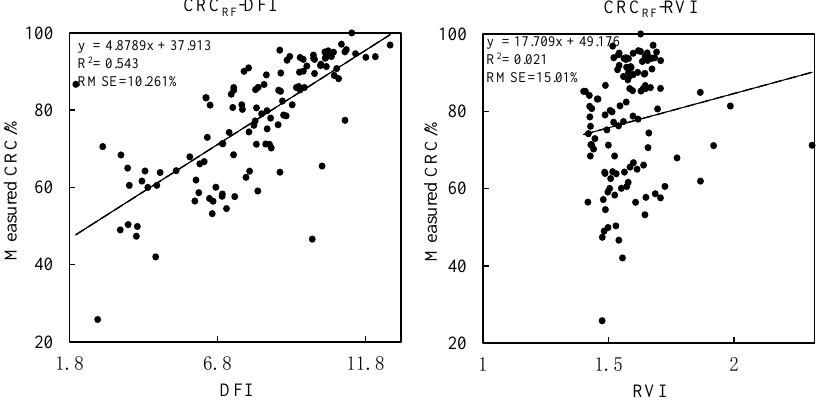
Figure 9. Response relationship between NDTI or STI and CRC RF based on Sentinel - 2.